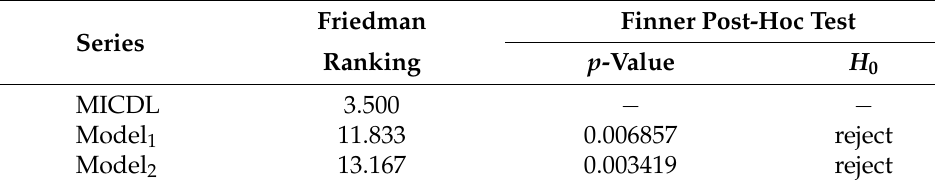
Table 12. FAR test and Finner post hoc test based on the Sen